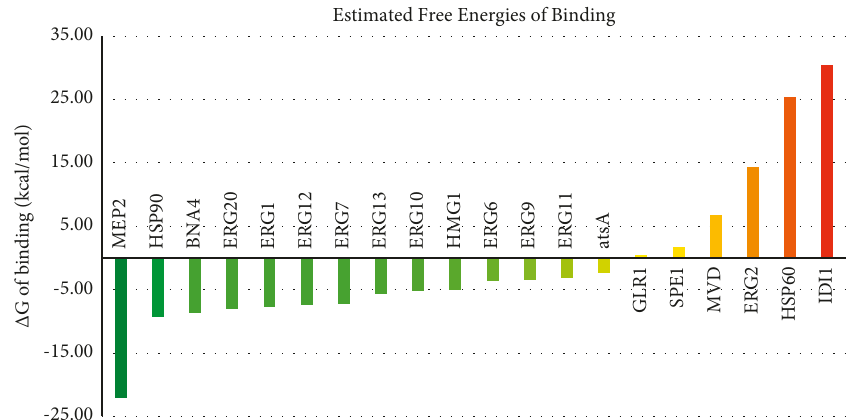
Figure 1: Predicted free energies of binding of compound 2 to its potential targets ranked from best Δ G of binding (green) to worst